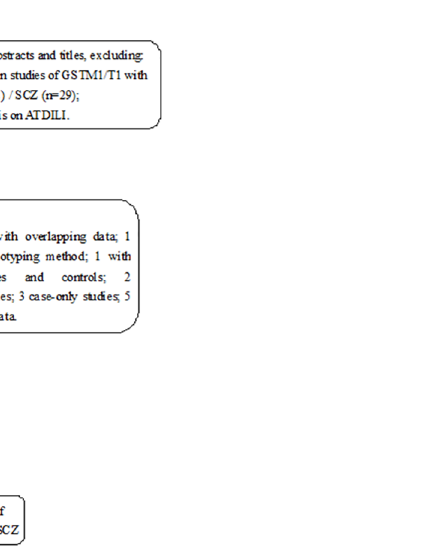
Fig 1. A flow diagram of the study selection